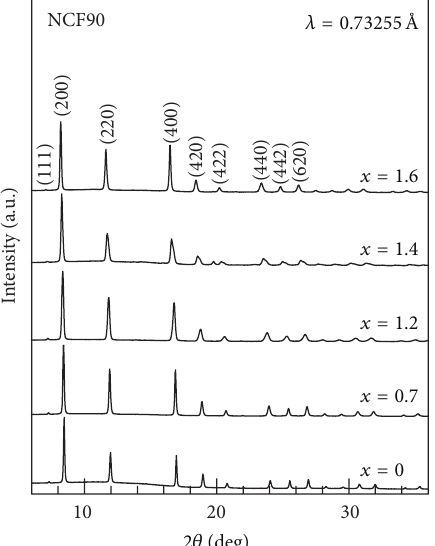
Figure 20: XRD pattern of powered NCF90 against Na concentra- tion( 𝑥 ).Valuesinparenthesesrepresentindexesintheface-centered cubic setting (cited from